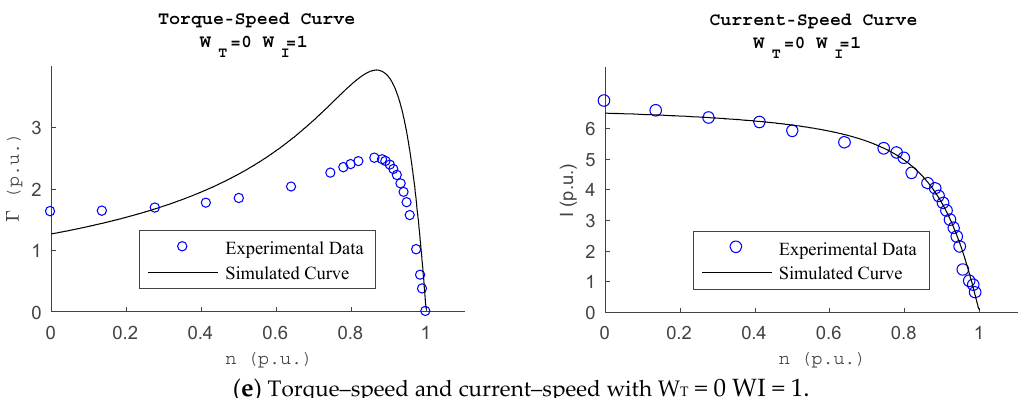
Figure 9. Torque–speed and current–speed curves with different objective function weights. For all cases, the weight for each operating zone is 0.33.